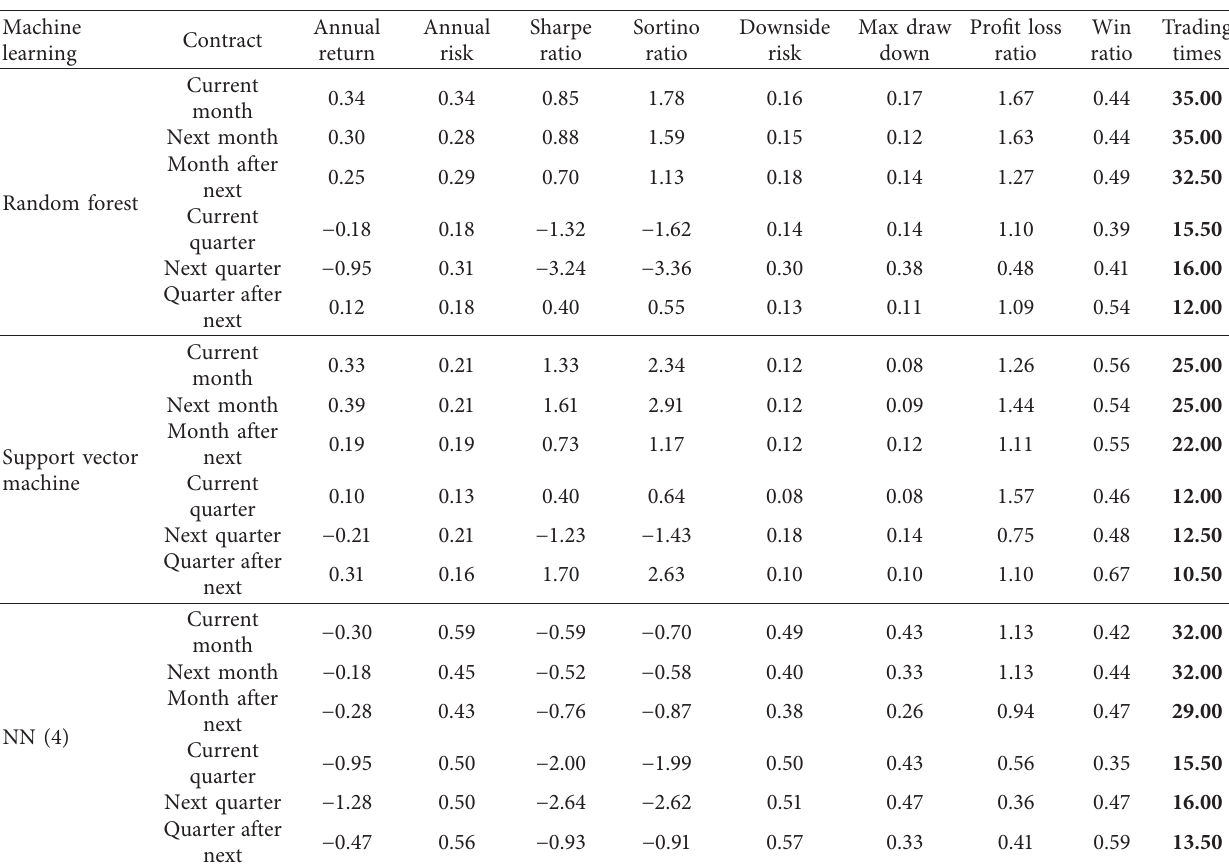
Table 7: Option strategy of predicting the rise and fall of volatility by threshold (use 8 features M1, threshold � 0.3).